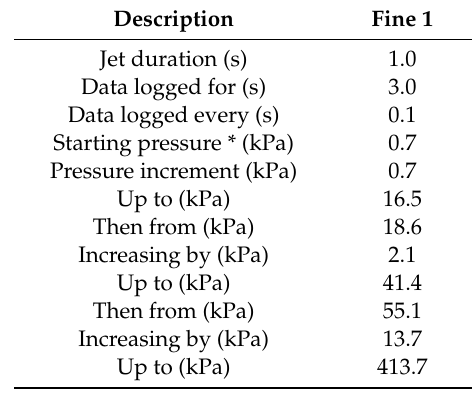
Table 1. Specification of the Fine 1 cohesive strength meter (CSM) routine (Partrac,